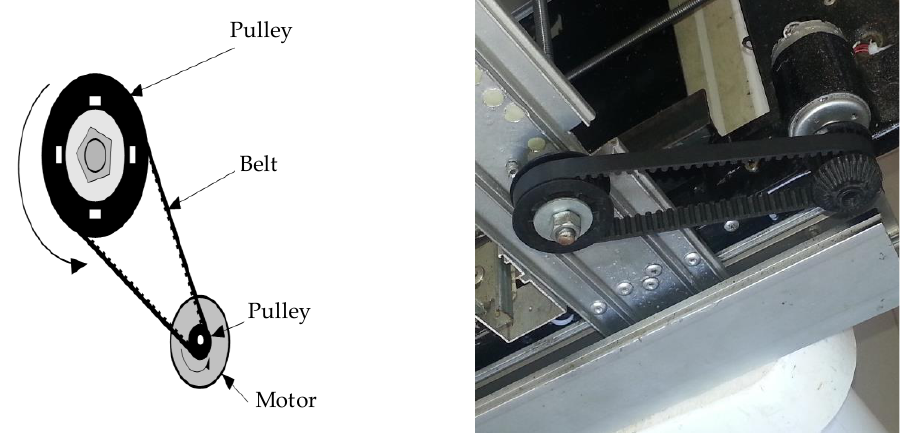
Figure 2. Transmission system for the Y axis.